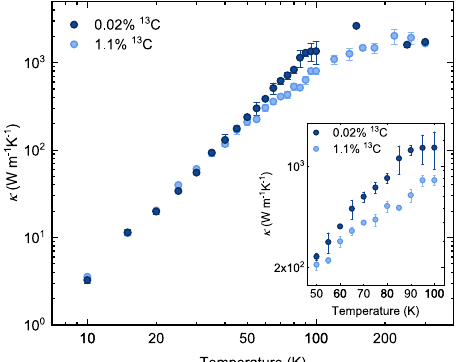
Fig. 2 | Temperature-dependent in-plane thermal conductivity ( κ ) of iso- topically puri fi ed and natural graphite ribbons with a designed width of 5.5 μ m. The dark and light blue dots represent the results of isotopically puri fi ed (0.02% 13 C)andnatural(1.1% 13 C)graphiteribbons,respectively.Notethattheactual width of the natural graphite ribbon is 0.8 μ m wider than that of the isotopically puri fi ed one due to the deviation in fabrication, resulting in the minor fl ip of thermal conductivities at very low temperatures. Inset: thermal conductivity from 50to100K.Errorbarsdepictthestandarddeviationsofdifferentmeasurementson the same